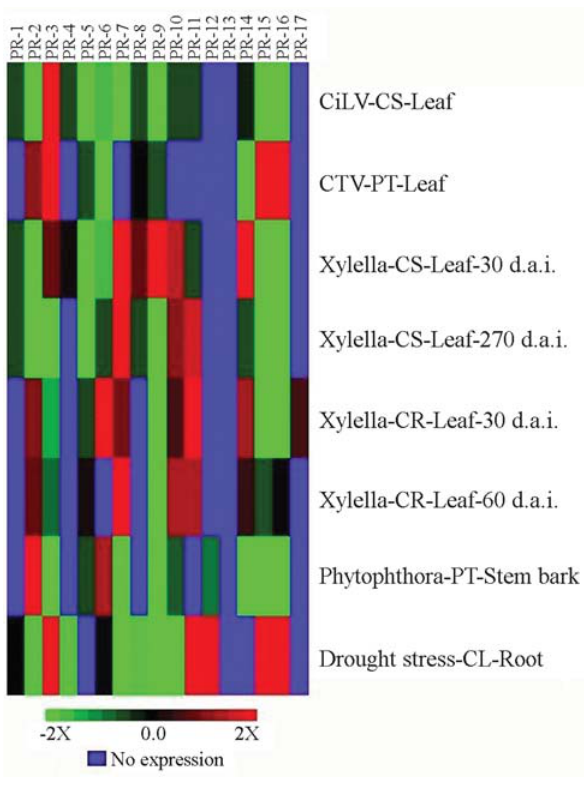
Figure 2 - In silico differential expression profiles of putative PR gene families (PR-1 to PR-17) in cDNA CitEST libraries from citrus organs in- duced by pathogen or drought stresses. Each subtracted stress situation (treatment vs. control) is represented by a single row; each PR -like gene family is represented by a single column. The color bar represents the color scales between relative induction (intense red for larger than 2) or suppression (intense green for lower than -2) ranges in relation to the counterpart control library. Black means no change (ratio 0) and blue no expression. CiLV, citrus leprosis virus; CTV, citrus tristeza virus; Xylella, X. fastidiosa ; Phytophthora, P. parasitica ; CS, C. sinensis ; CR, C. reticulata ; CL, C. limonia ; PT, Poncirus trifoliata . D.A.I., days after inoc-